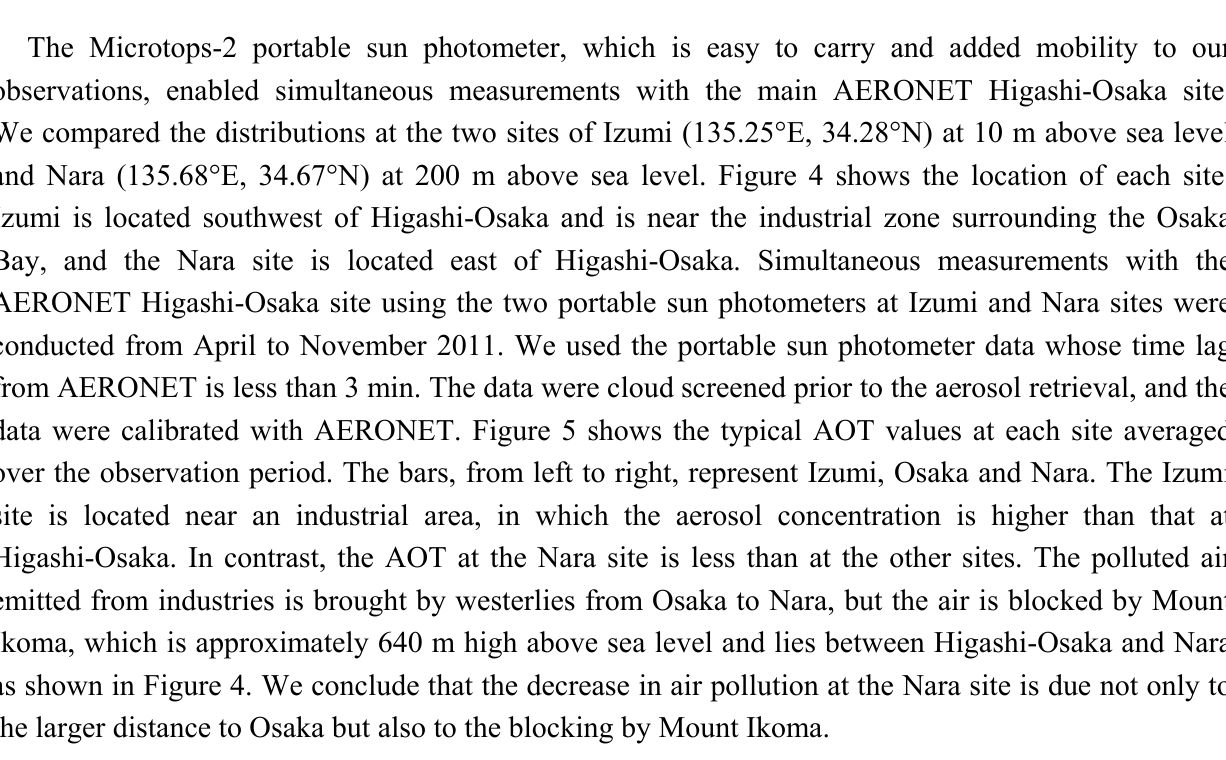
Figure 4. Map of observation sites. Higashi-Osaka is located at 135.59E,